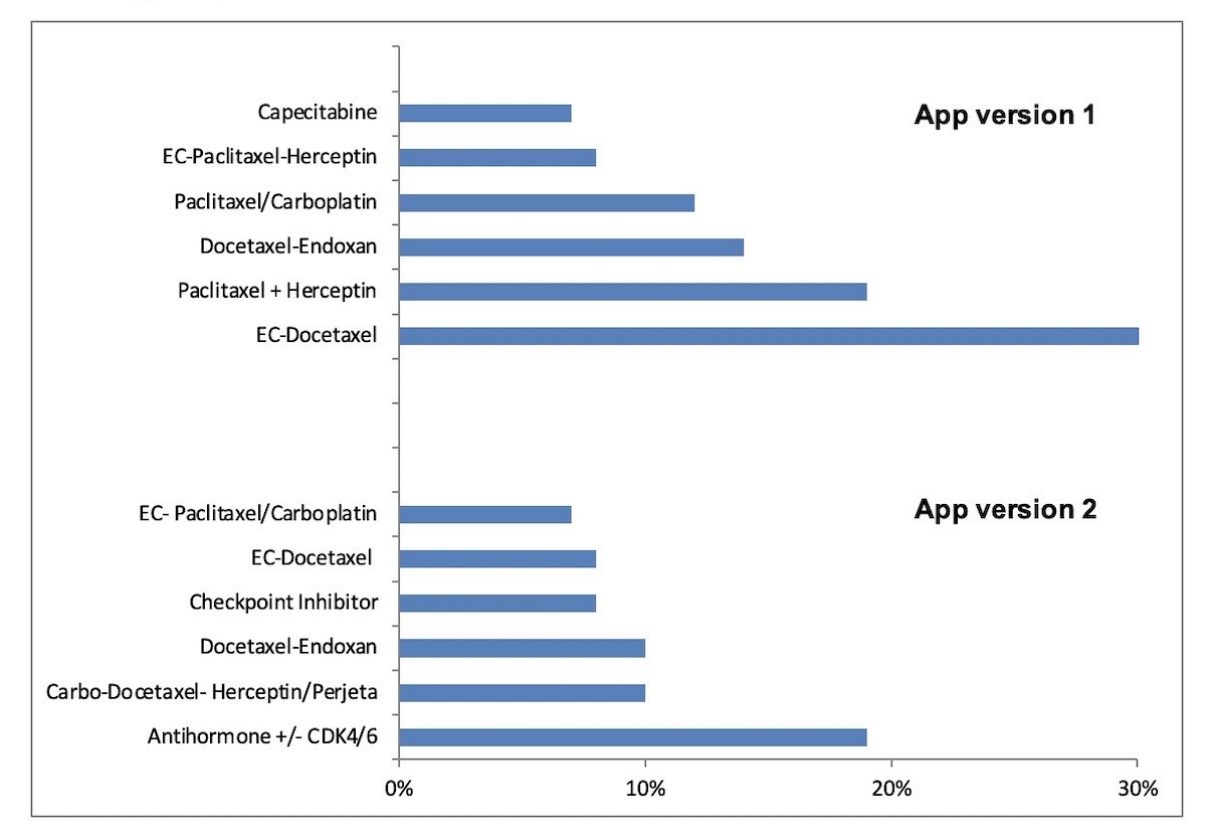
Figure 2. Frequency of the most commonly applied anticancer therapies during Consilium app